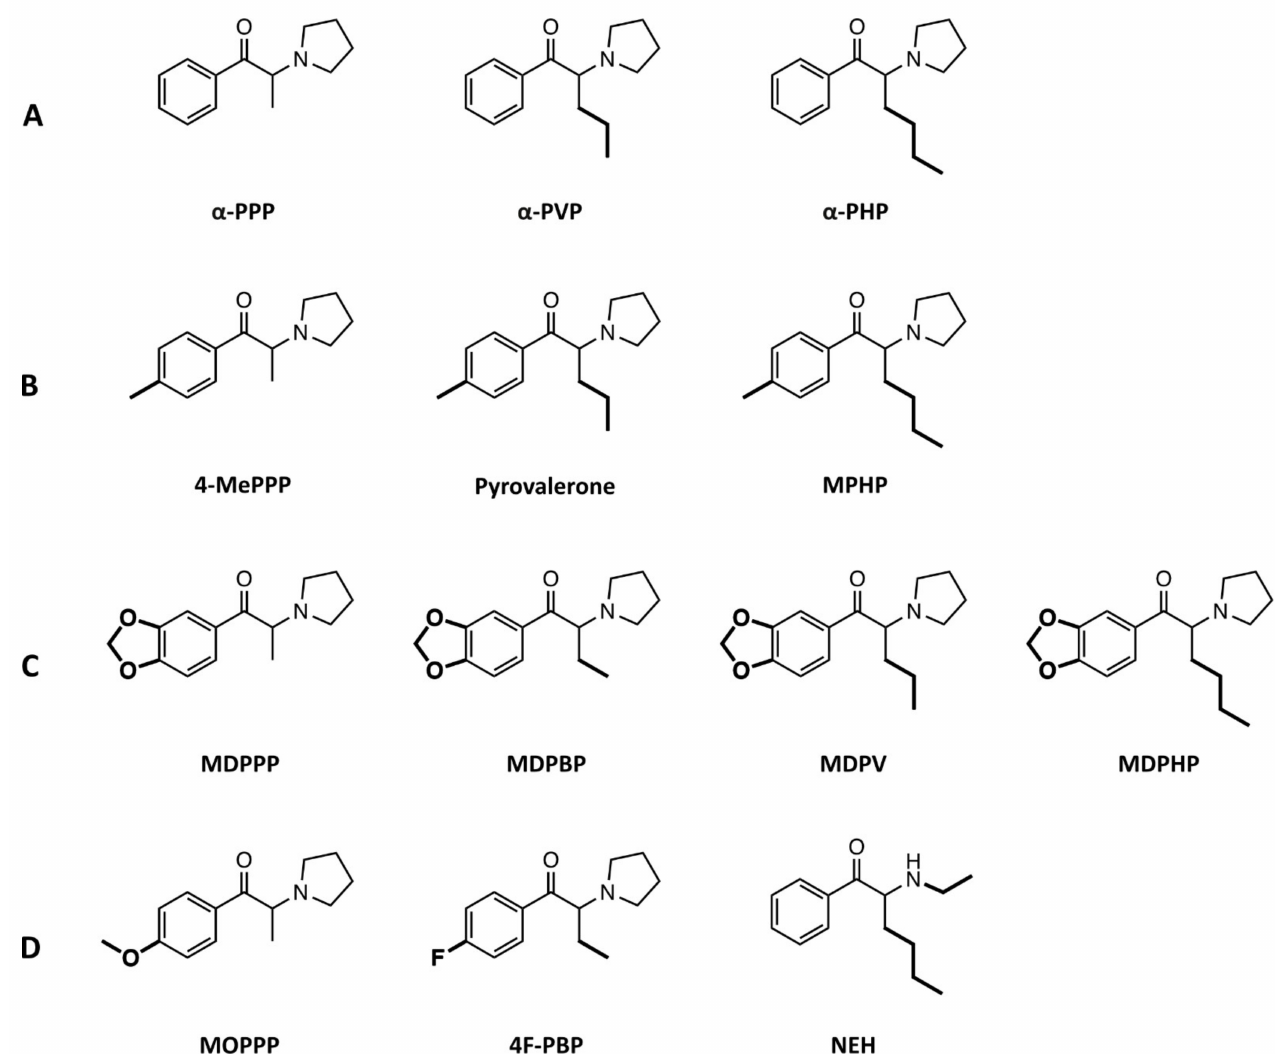
Figure 1. Chemical structures of pyrovalerone cathinones and NEH. Substances subdivided into ( A ) compounds with substitutions only onto the α -carbon either methyl ( α -PPP), propyl ( α -PVP) or butyl group ( α -PHP), ( B ) compounds with a 4-methyl group and an insertion of a methyl (4-MePPP), propyl (pyrovalerone) or butyl group (MPHP) on to the α -carbon group, ( C ) compounds with 3,4-methylenedioxy insertion onto ring structure (MDPPP) and insertion of ethyl (MDPBP), propyl (MDPV) or butyl (MDPHP) group onto the α -carbon moiety, and ( D ) compounds with a 4-methoxy (MOPPP) or 4-fluorine substitution on ring structure, and related cathinone lacking the pyrrolidine moiety at the nitrogen atom (NEH). All described structural modifications are indicated in